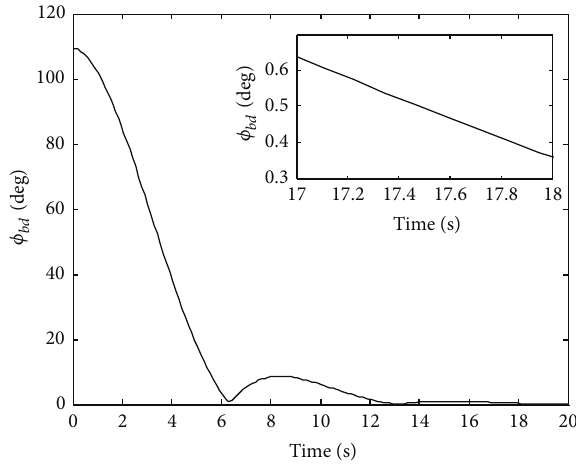
𝑇 . Figure 7: Attitude responses; Theorem